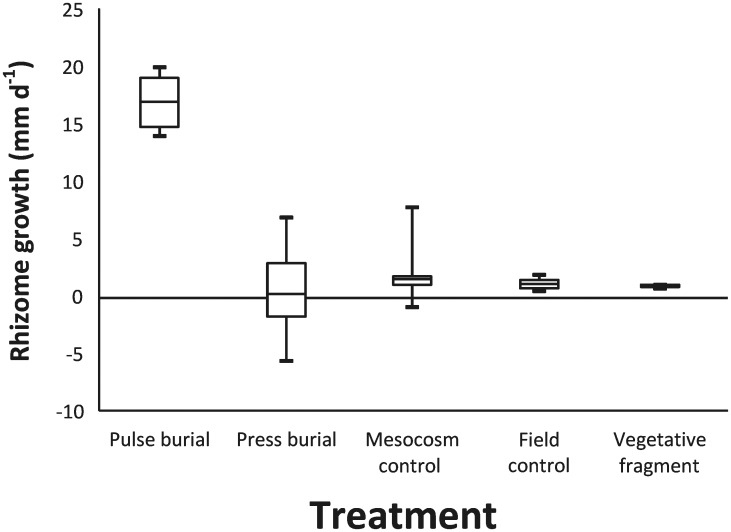
Box plot of Posidonia australis net rhizome extension rates (mm d-1) by treatment.The central solid line represents the median (50% Quartile); the top and bottom of the box represent the 25% and 75% Quartiles, respectively; and the vertical bar represents the observed range of maximum and minimum values.